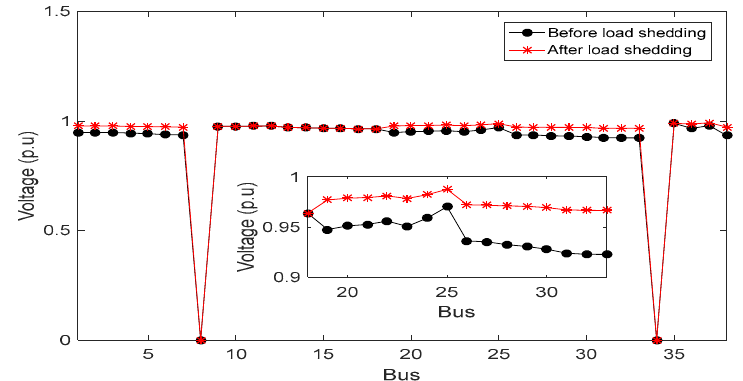
Figure 12. Bus voltages at faulted bus #8 prior to and after load shedding.